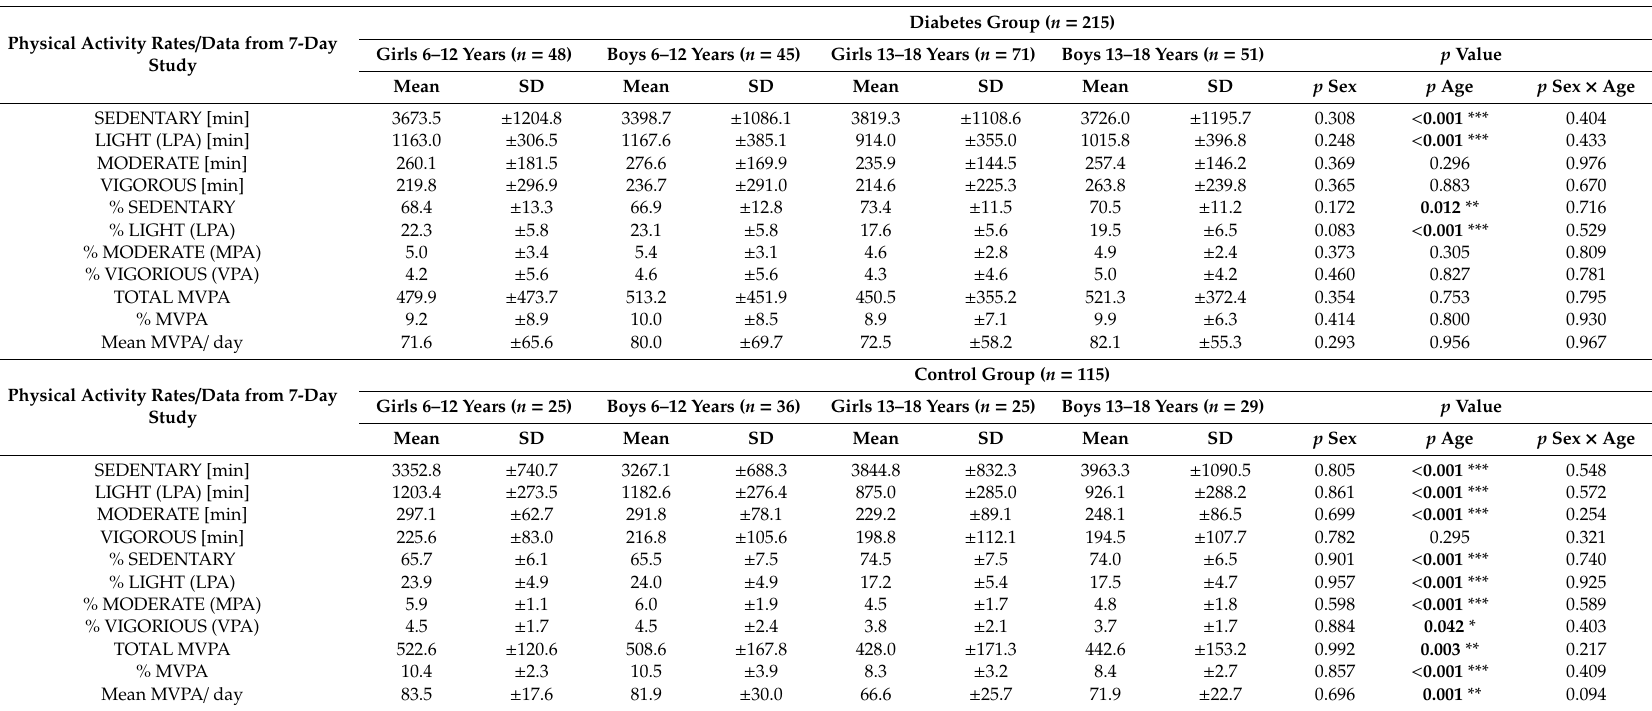
Table 9. Physical activity rates in the diabetes and the control groups depending on sex and